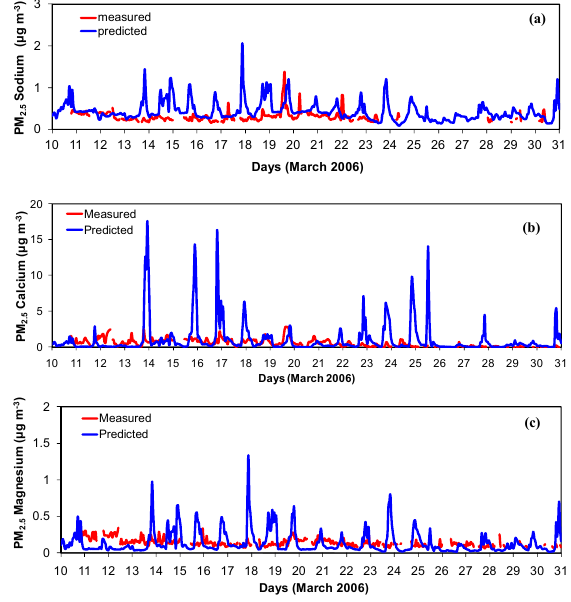
Fig. 9. Comparison of model hourly predictions against measure- Figure 9: Comparison of model hourly predictions against measurements for PM 2.5 (a) sodium, ments for PM 2 . 5 (a) sodium, (b) calcium, (c) magnesium taken at (b) calcium, (c) magnesium taken at T1 during the MILAGRO campaign. T1 during the MILAGRO